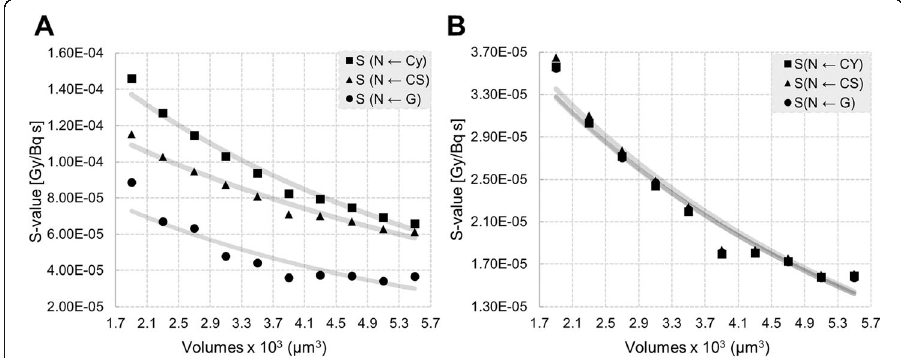
Fig. 6 Effect of cellular volume and source location on the self-dose a and cross-dose b dose to nucleus. Square, triangle and circle correspond to the radioactive source distributed in cytoplasm, membrane and Golgi,